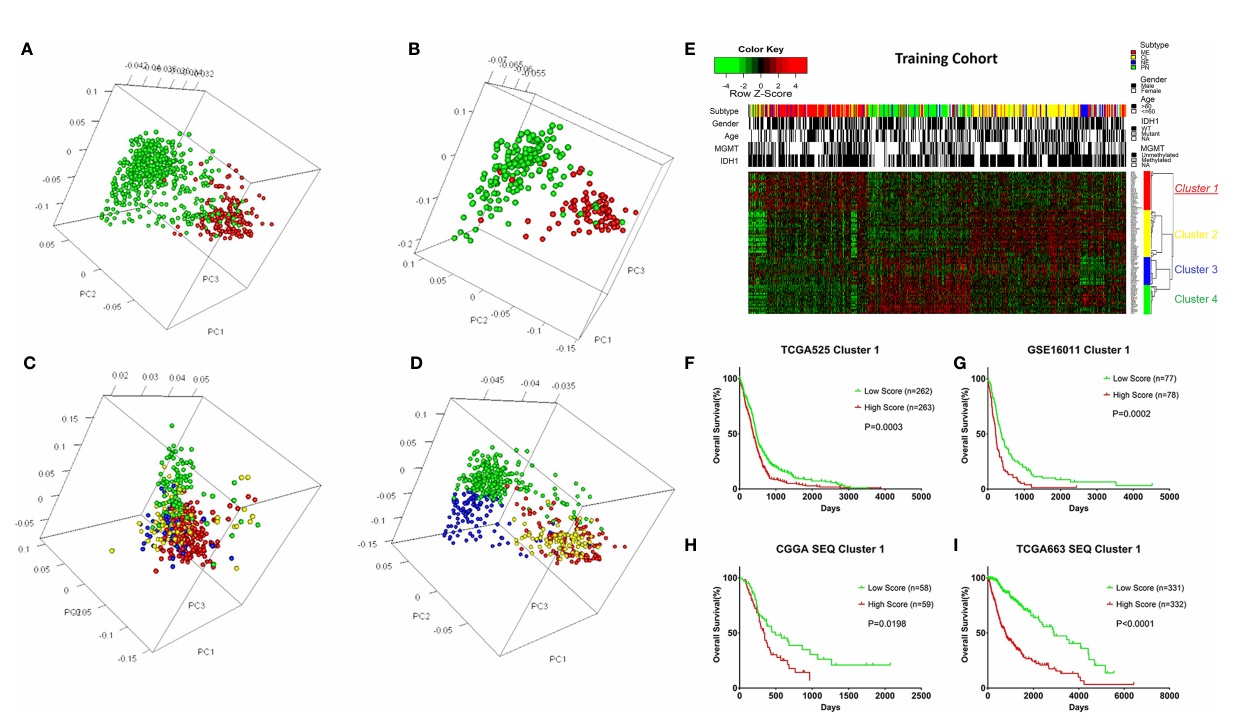
FIGURE 1 | Overview of the transcription factors (TFs) used to stratify different grades, prognosis, and subtypes of glioma, and the selection of the TF signature with its prognostic value across cohorts. (A) Principle component analysis (PCA) indicating that the TFs could distinguish LGG from GBM in the TCGA RNA-seq cohort. Green: LGG; Red: GBM. (B) PCA indicating that the TFs could distinguish long-term survival from short-term survival in the TCGA RNA-seq cohort. Green: OS > 3 years; Red: OS < 1 year. (C) PCA indicating that the TFs could distinguish different transcriptional subtypes of GBM in the training cohort. Green: PN; Blue: NE; Yellow: CL; Red: ME. (D) PCA indicating that the TFs could distinguish different transcriptional subtypes of glioma in the TCGA RNA-seq cohort. Green: PN; Blue: NE; Yellow: CL; Red: ME. (E) Heatmap depicting the Z-scored expression values and the clustering of 88 key TF genes in the training cohort. Columns represent each sample and are labeled with their clinical characteristics, rows represent genes and were clustered into four groups. Cluster 1 represents the signature. (F) Kaplan – Meier survival analysis based on the median cutoff value of the risk score developed using the cluster 1 gene set in the training cohort. (G) Kaplan – Meier survival analysis based on the median cutoff value of the risk score developed using the cluster 1 gene set in the GSE16011 cohort. (H) Kaplan – Meier survival analysis based on the median cutoff value of the risk score developed using the cluster 1 gene set in the CGGA RNA-seq cohort. (I) Kaplan – Meier survival analysis based on the median cutoff value of the risk score developed using cluster 1 gene set in the TCGA RNA-seq cohort. LGG, Lower grade glioma; Mutant, IDH1 mutant; WT, IDH1 wild type; NE, Neural; PN, Pro-neural; CL, Classical; ME, Mesenchymal; NA, Not